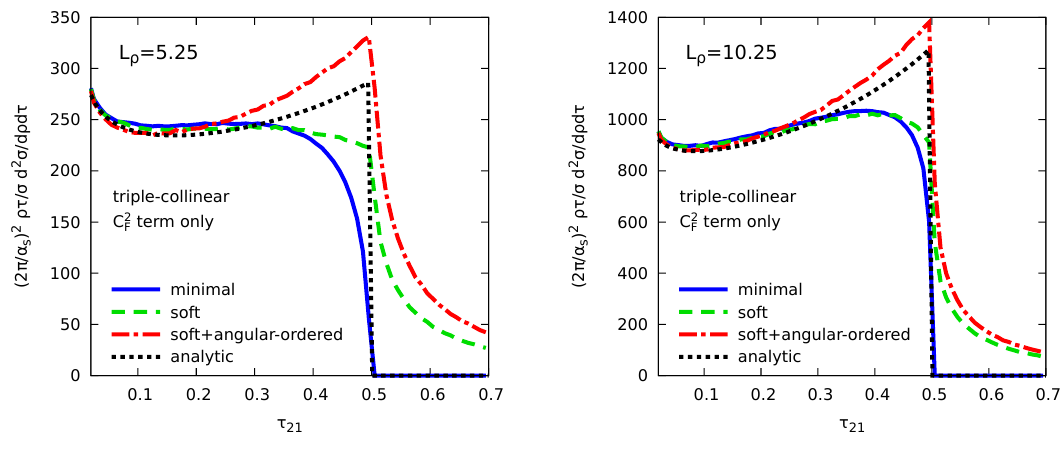
) in the triple-collinear limit, obtained with di(cid:11)erent approx- s